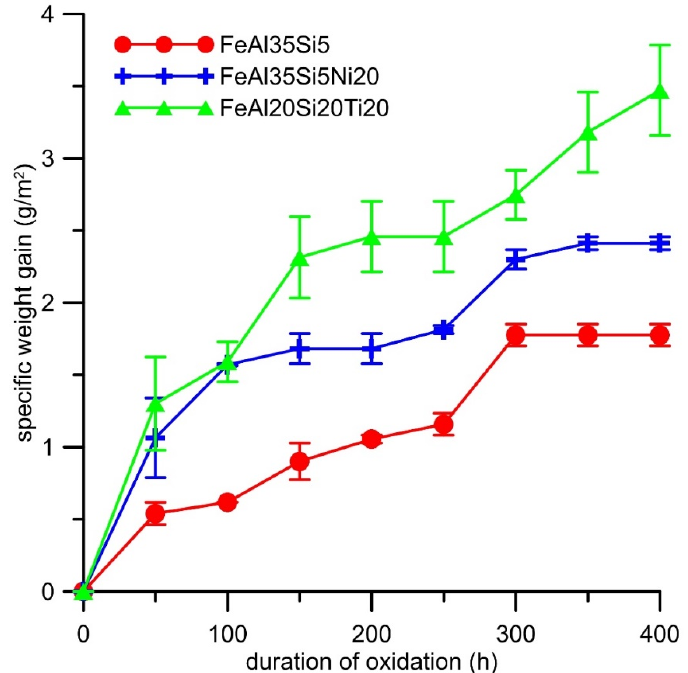
Figure 7. Dependence of specific weight gain (g ∙ m − 2 ) on the duration of cyclic oxidation at 800 °C in air.